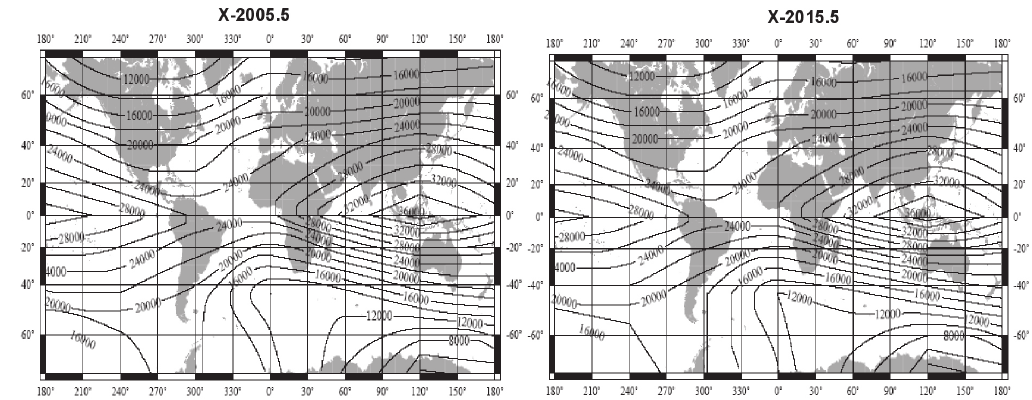
Fig. 12. Isolines of Z-Component predicted by the Neural Networks for two different